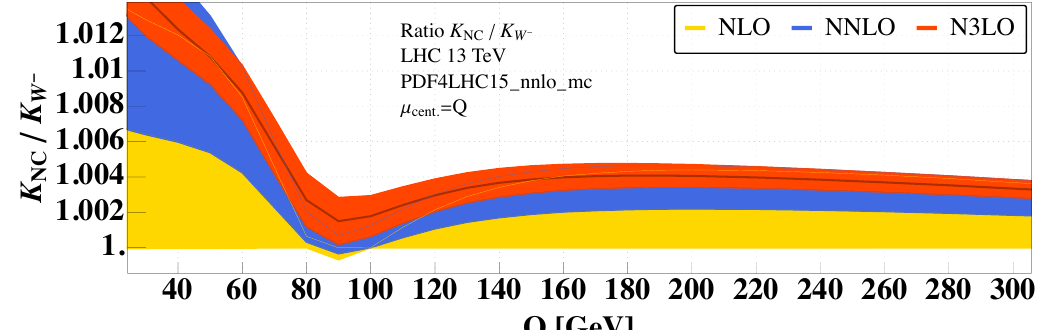
Figure 9. Ratio of the K-factors for NCDY and W − production as a function of Q 2 at different orders in perturbation theory.